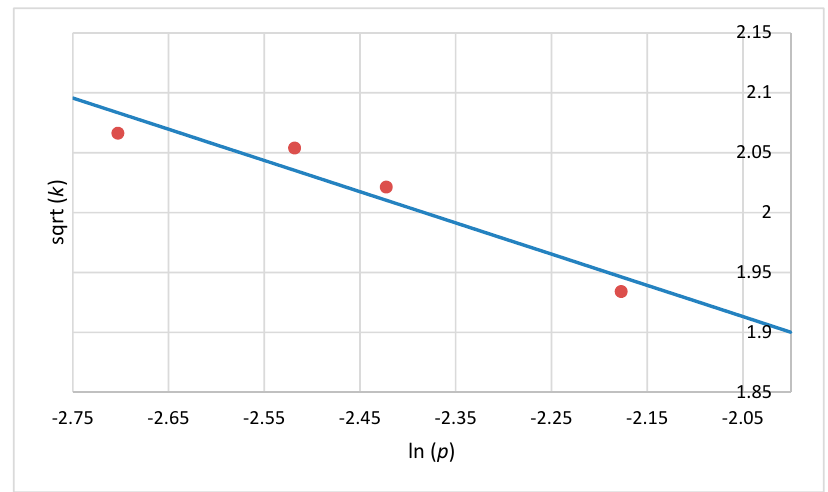
Figure 3. Linear relationship between ln ( p ) and sqrt ( k ) for B. cereus on the cardamom seed matrix, where p and k are the scale and shape parameters of the Weibull model (Equation (5)). Sqrt ( k ) was modelled using the linear correlation between ln ( p ) and sqrt ( k ). The fitted equations for B. cereus (R 2 = 0.90, R 2 = 0.92 for juniper berry and cardamom seed matrix, respectively, Equations (4) and (5)), B. subtilis (R 2 = 0.90, R 2 = 0.92 for juniper berry and cardamom seed matrix, respectively, Equations (6) and (7)) and B. pumilus inactivation (R 2 = 0.98, R 2 = 0.98 for juniper berry and cardamom seed matrix, respectively, Equations (8 ) and (9)) were written as: